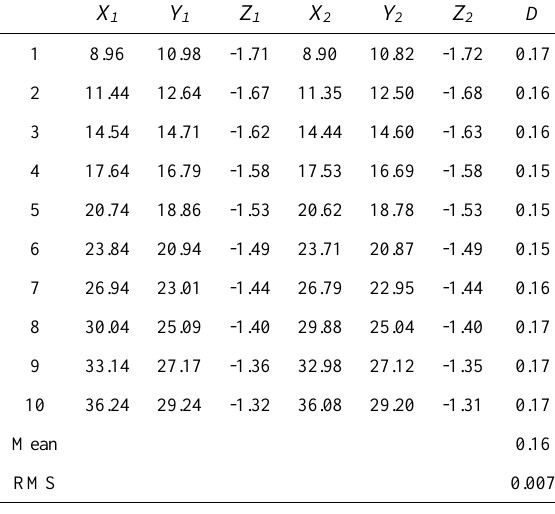
Table 1. Comparison of the central axes unit: mm